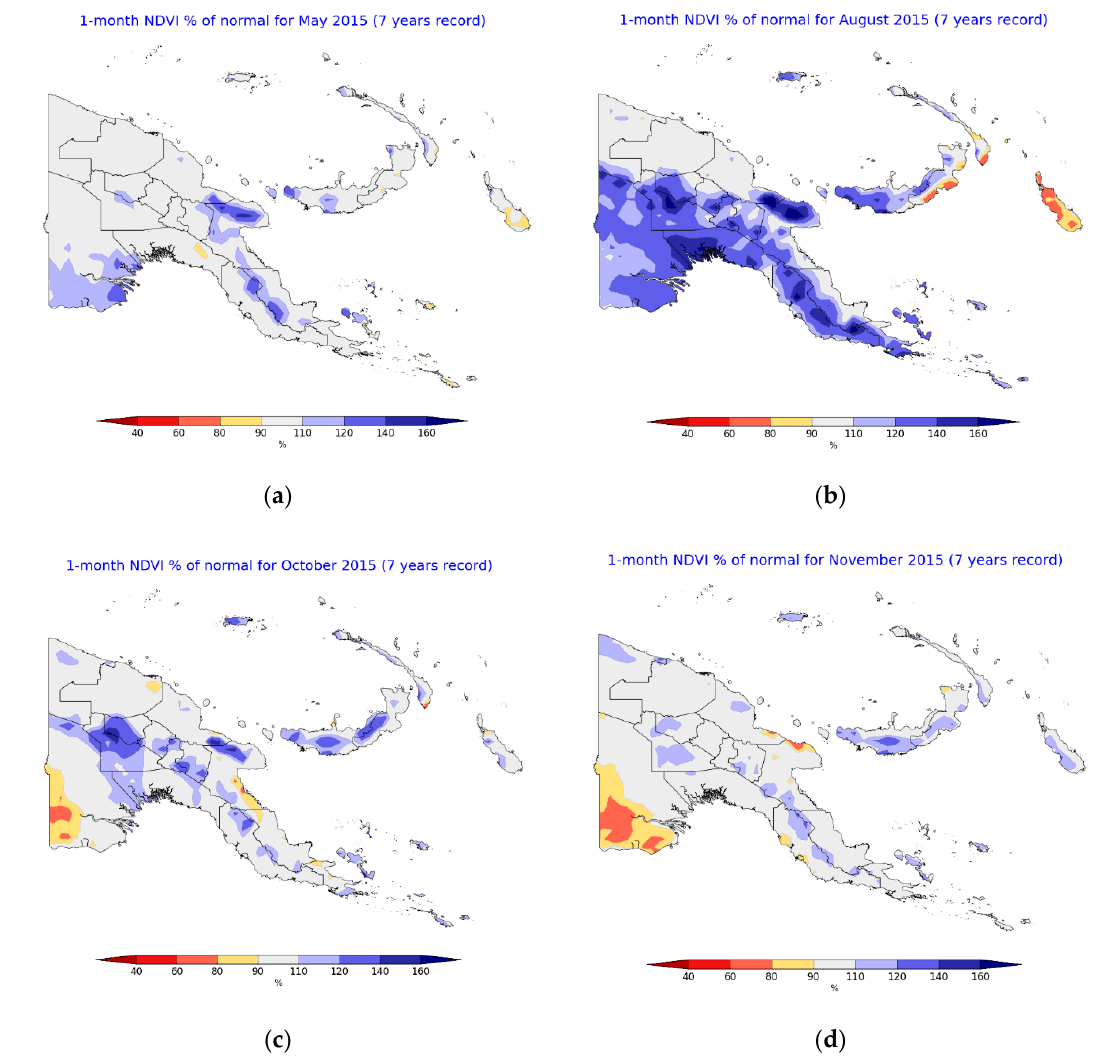
Figure 11. Normalized difference vegetation index (NDVI) percentages of normal showing the progression of the 2015–2016 drought event. ( a ) June 2015 showing initial signs of above-average vegetation health; ( b ) August 2015 showing widespread above-average vegetation health; ( c ) October 2015 showing some below-average vegetation health towards the far southwest; ( d ) November 2016 showing some areas of below-average vegetation health and easing of above-average vegetation health.